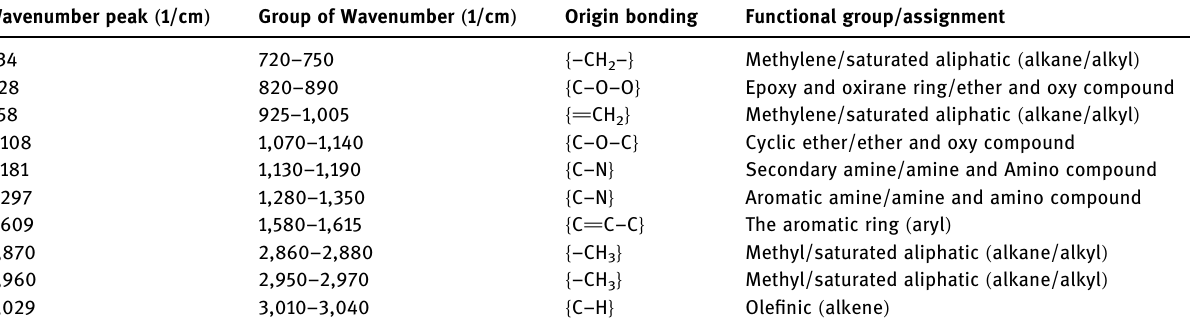
Table 2: Thermoset epoxy resin functional groups detected as infrared wavenumber peaks by FTIR ( assignment refers to Coates [ 20 ]) Wavenumber peak ( 1/cm